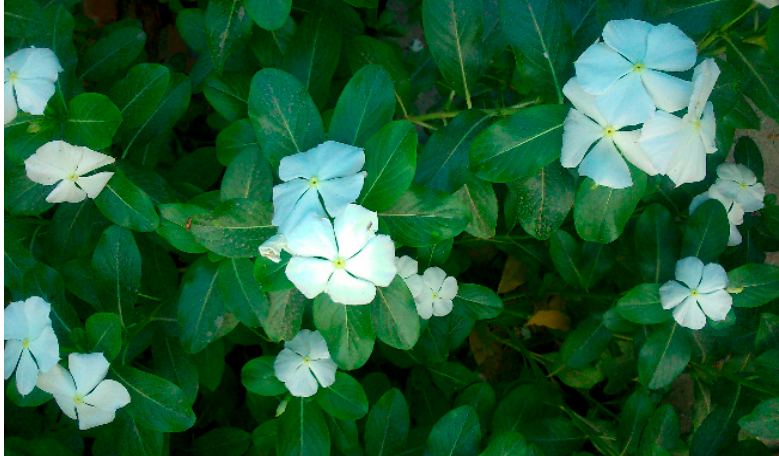
Figure 1. Catharanthus roseus (L.) G. Don (Patricia White cultivar) (Pham, 2014).